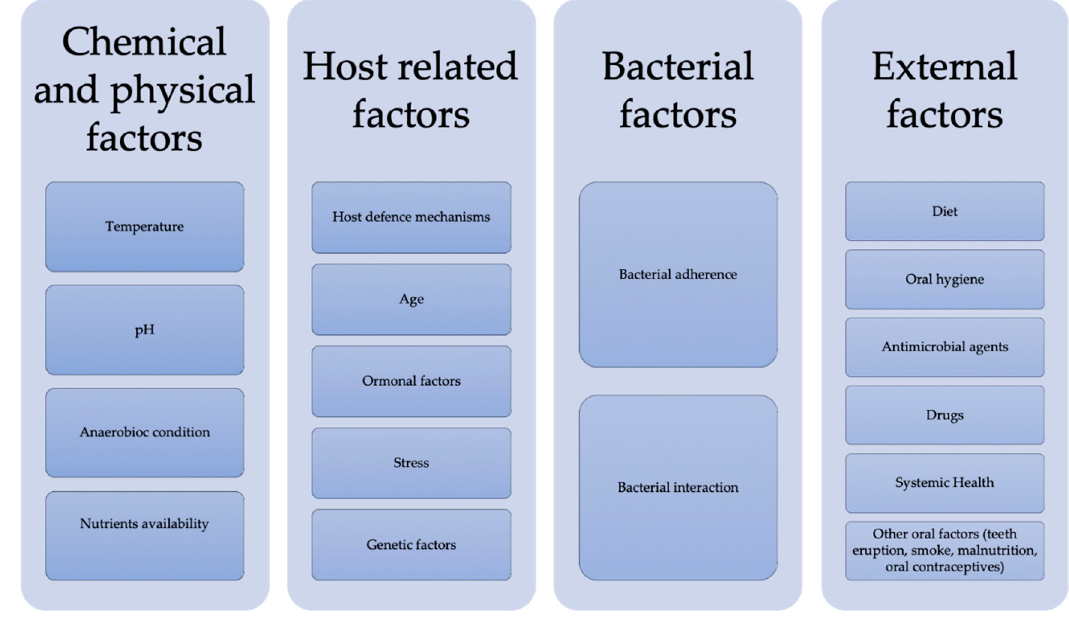
Figure 1. Factors that influence the oral ecosystem.